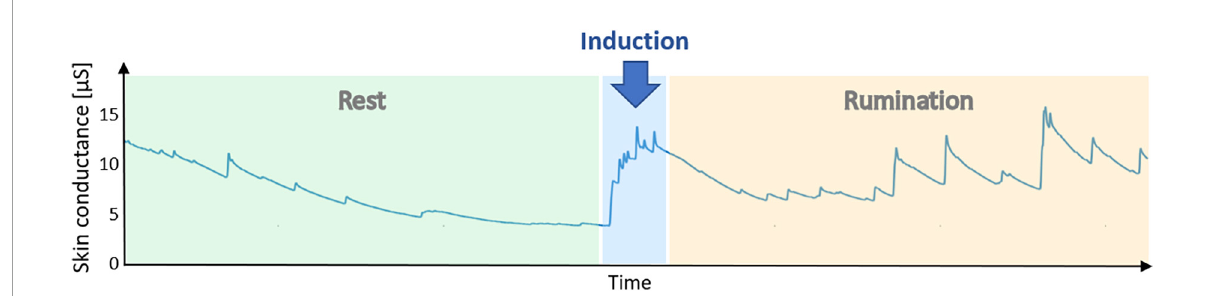
FIGURE1 Example time course of skin conductance during a laboratory session. After 10 min of resting state, instructions to engage in rumination were displayed. The rumination phase lasted another 10 min. An elevation of skin conductance during the rumination phase indicates sympathetic activation elicited by ruminative